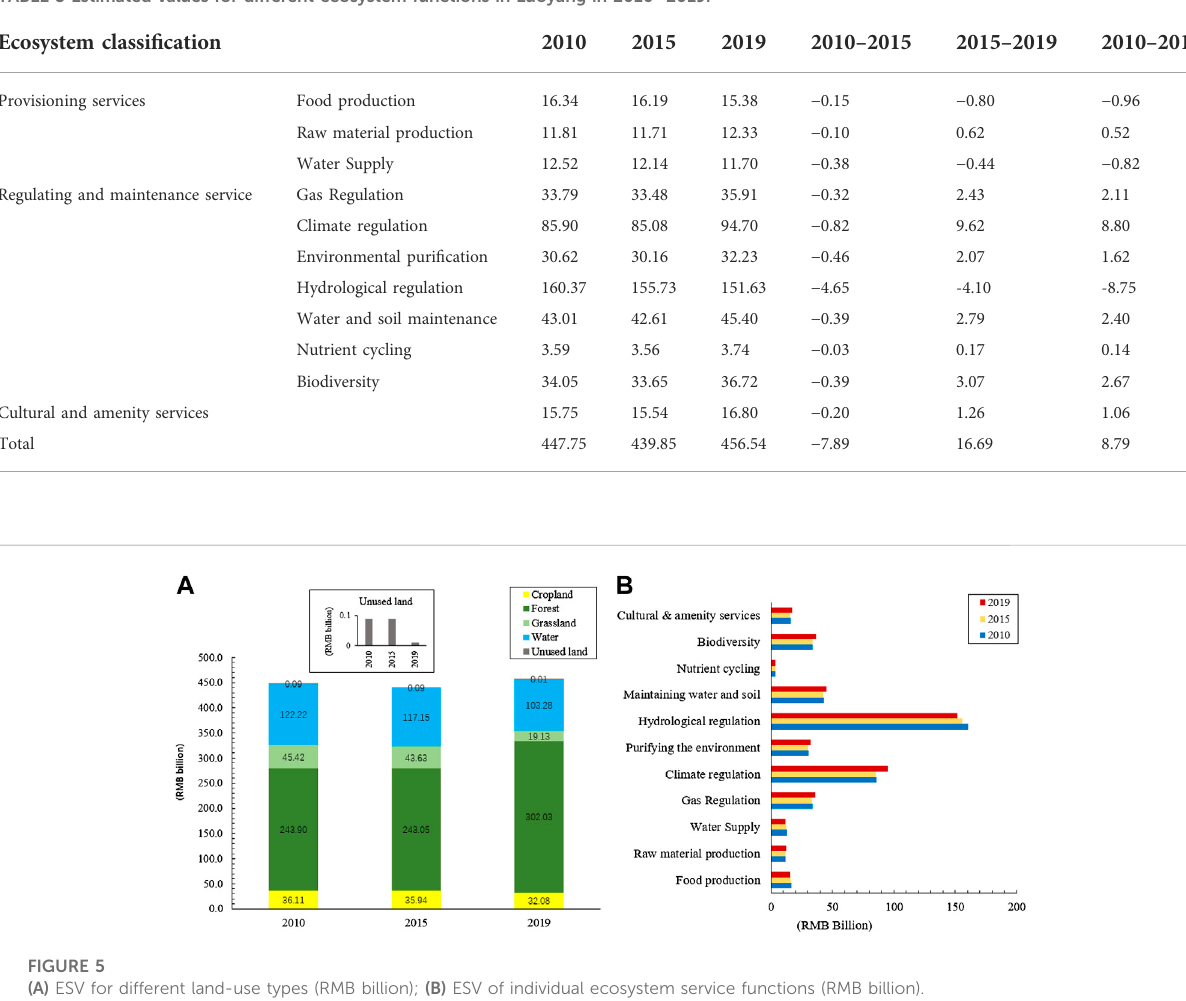
TABLE 5 Estimated values for different ecosystem functions in Luoyang in 2010 –